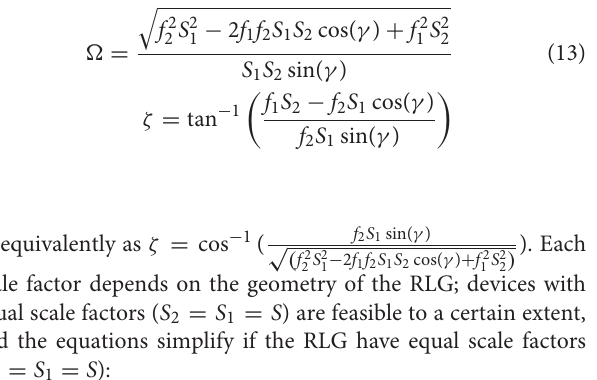
and the angle, respectively. The sensitivity of the RLG at ζ is slightly better 3.9210 − 11